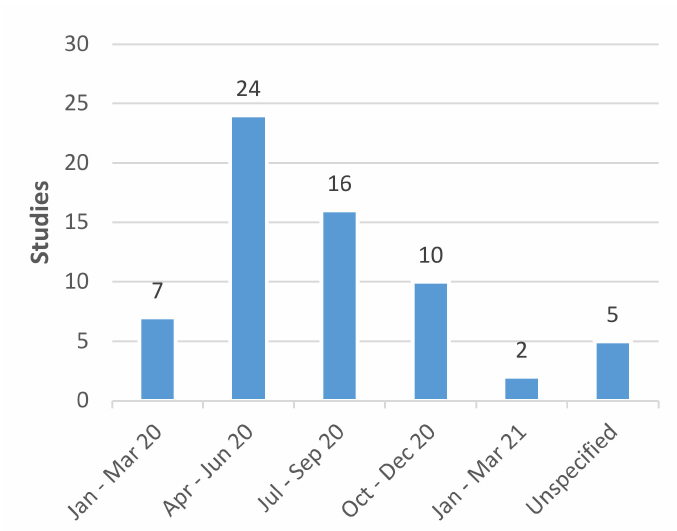
Figure 5. Data collection periods covered by included studies, by